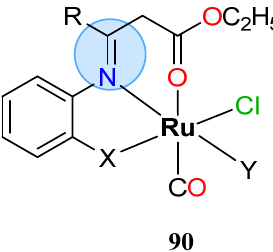
Figure 46. Ruthenium(III) complexes containing dibasic tridentate Schiff bases with antibacterial activity.